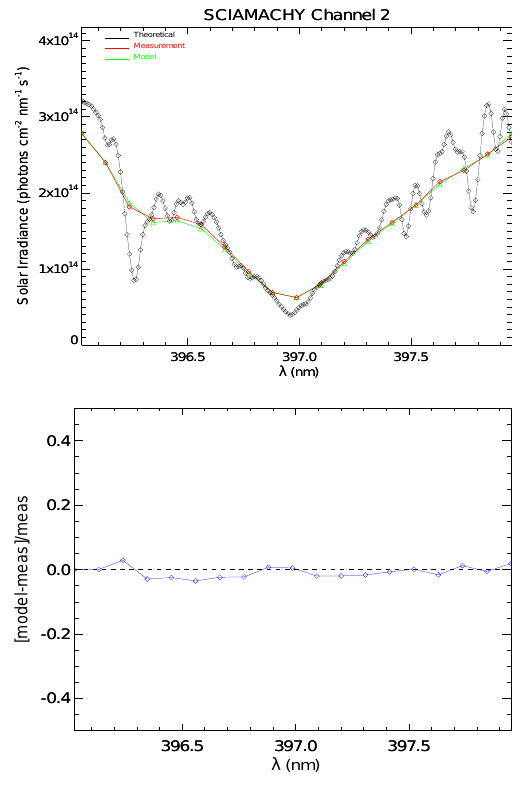
Figure 4. Similar to Figure 3 but for Channel 2 and Line 3. The corresponding retrieved ISRF is a Hyperbolic function with a FWHM (cid:39) 0.26 nm. The residuals ( bottom graph ) rms (cid:39)